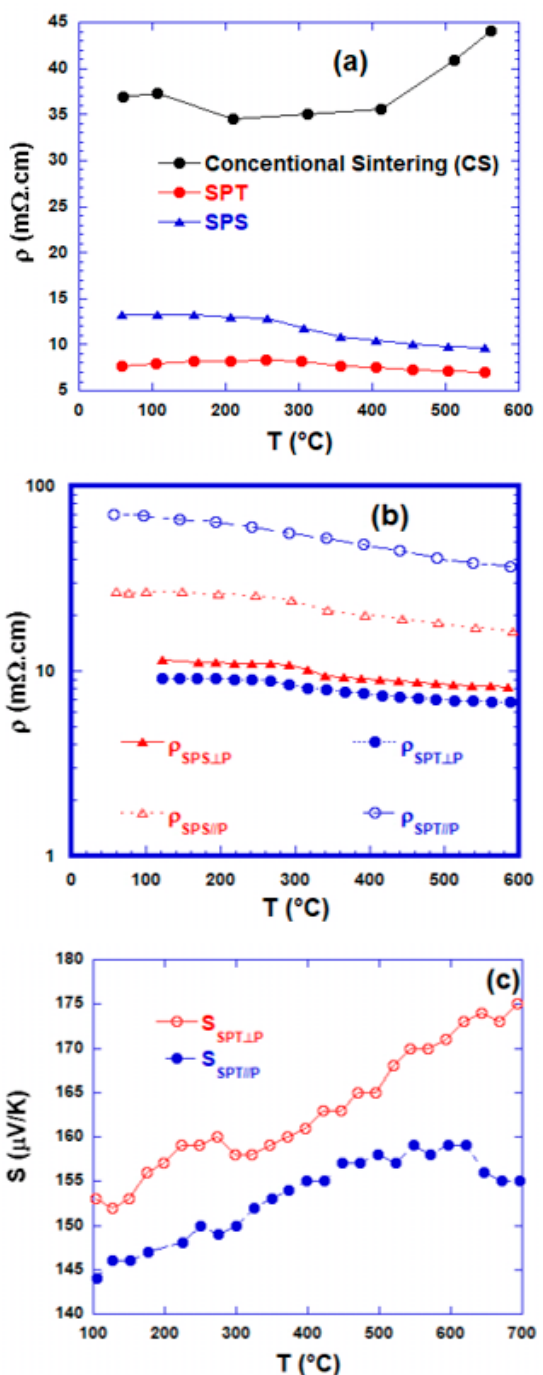
Figure 5. ( a ) Temperature dependence of the electrical resistivity on the conventional sintering (CS) sample, compared to in-planes SPS and SPT samples. ( b ) Temperature dependence of the electrical resistivity of in and out-planes samples processed by SPS and SPT respectively. ( c ) Temperature dependence of in and out-planes Seebeck coefficient for sample processed by SPT.